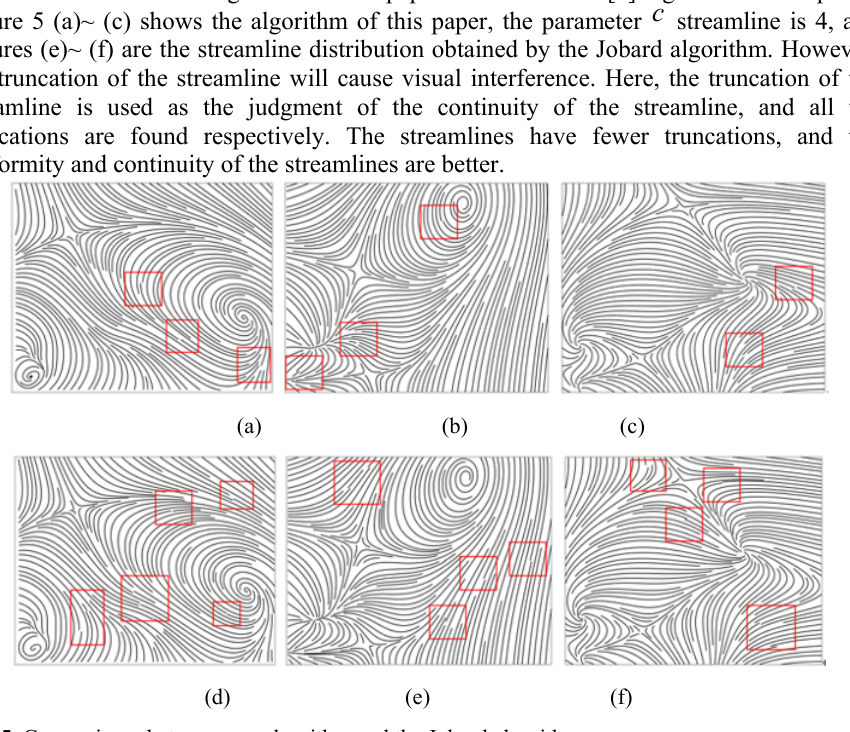
d , the grid parameters are: max s